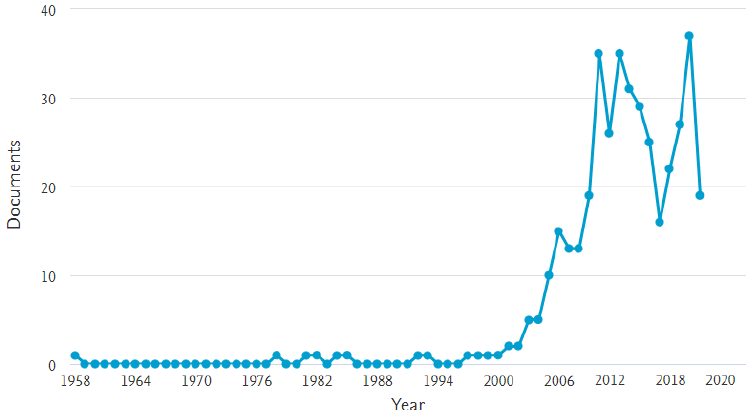
Figure 1. Evolution of the number of papers retrieved from the SCOPUS database with the string in Table